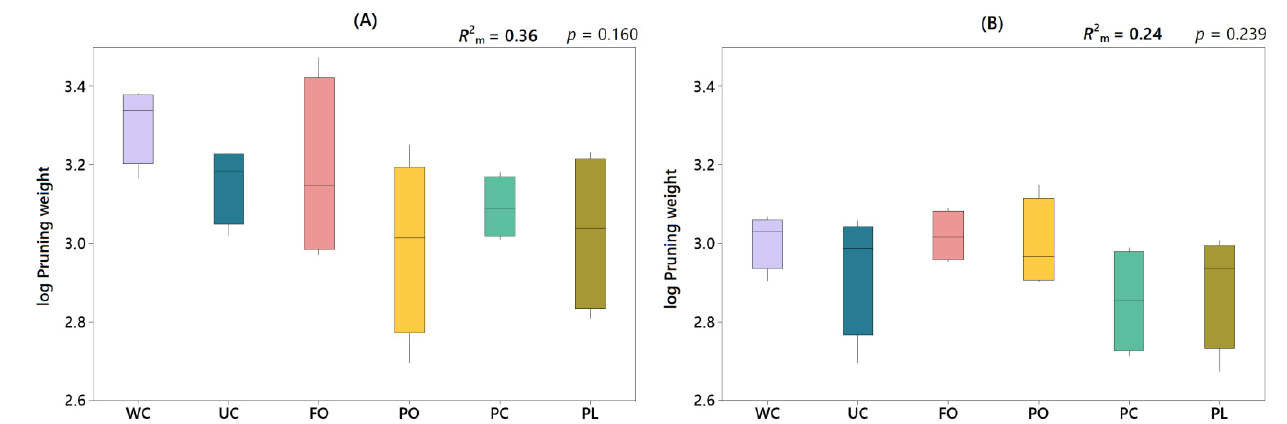
Figure 6. Grapevine vegetative growth (log pruning weight) according to the different treatments applied on farm A ( A ) and farm B ( B ): WC, weed-free control; UC, untreated control; FO, Festuca ovina living mulch; PO, Pilosella officinarum living mulch; PC, Plantago coronopus living mulch; PL, Plantago lanceolata living mulch. Marginal R-squared ( R 2m ) indicated in the upper right corner, is the variance explained by the fixed factors of the model, in this case by “treatment”.